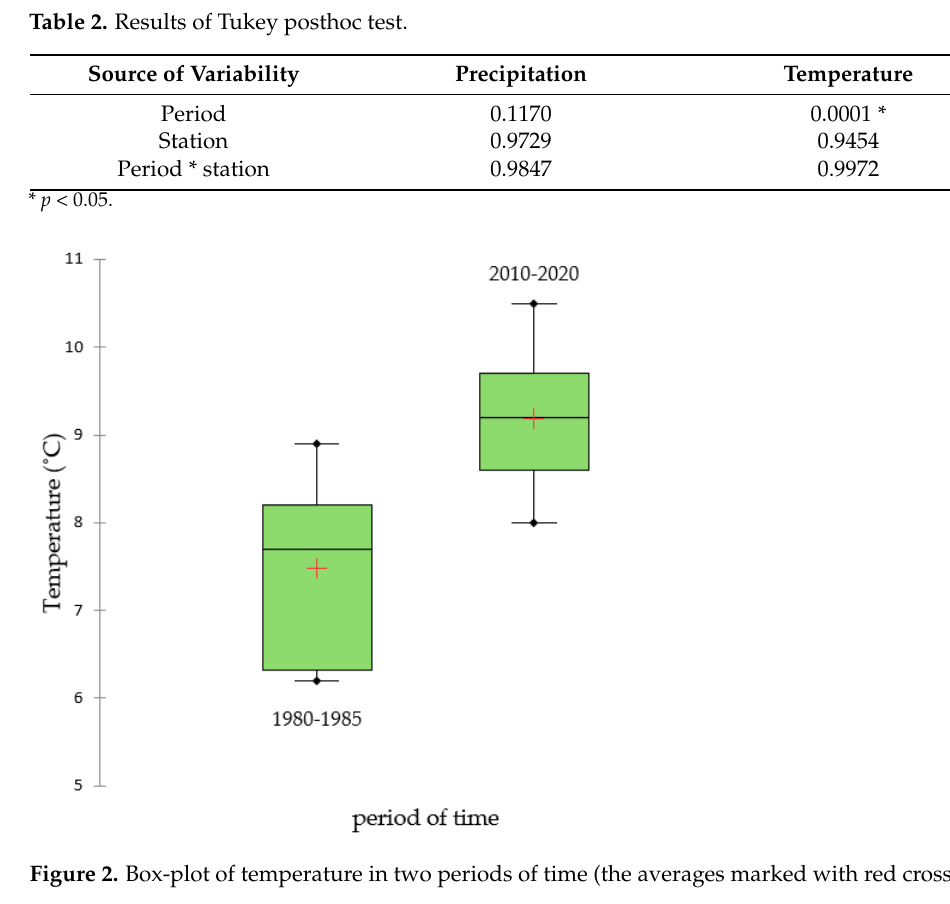
Table 2. Results of Tukey posthoc test.